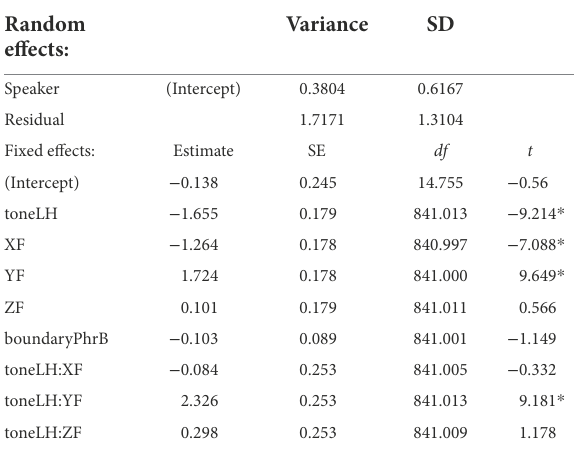
TABLE 3 LMM analysis on the difference of maximum F0 in the H tones before and after syllable X, with focus, boundary and tone as fixed factors, whereas speaker as a random factor in the formula as: difs7s5 ~ tone * focus + boundary + (1 |